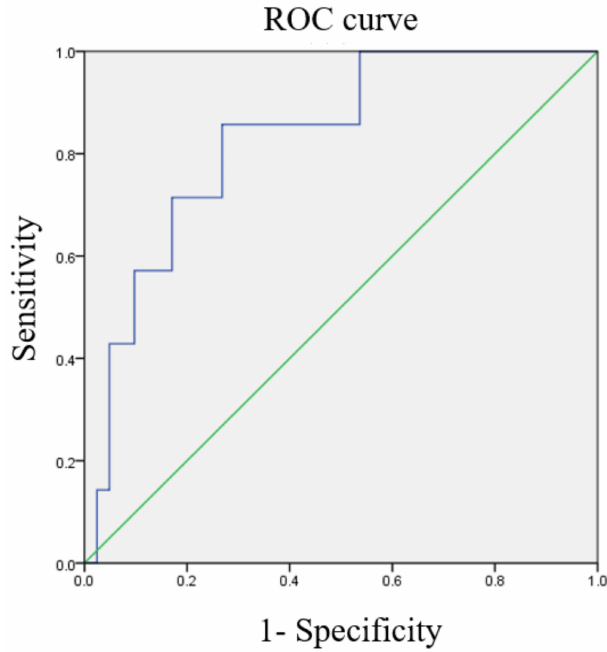
Figure 3. The receiver operating characteristic (ROC) curve of the monocyte/lymphocyte ratio predicts cancer death (area under the curve [AUC] =